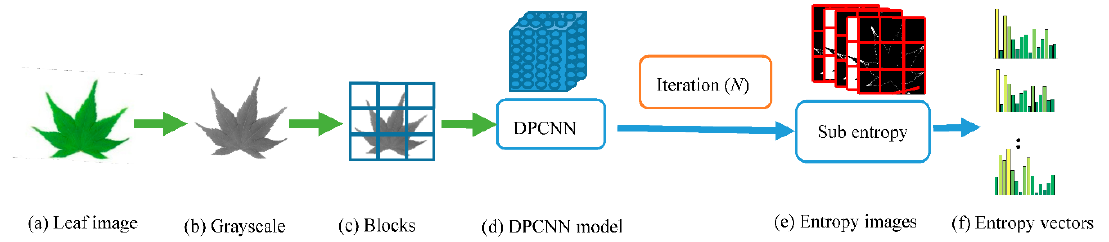
Figure 4. Flow of getting entropy vector.